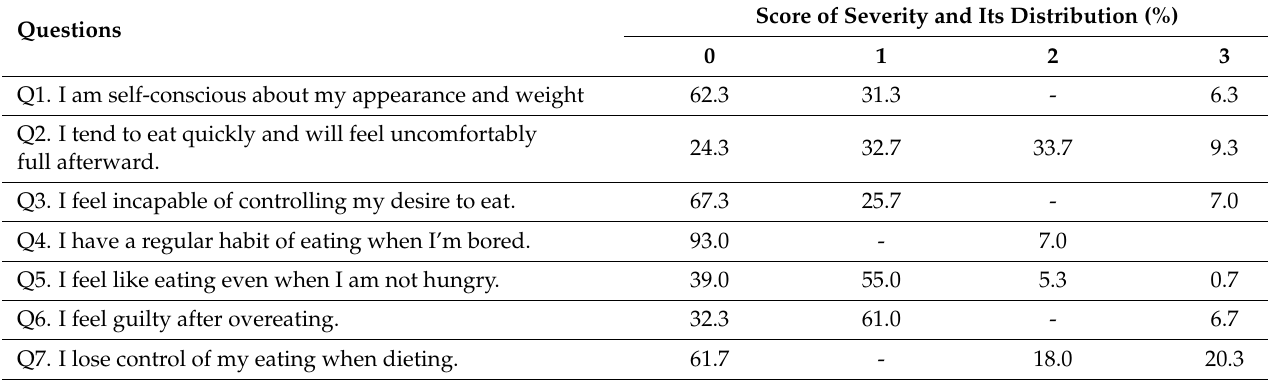
Table 2. Distribution of responses to the Binge Eating Scale (n =